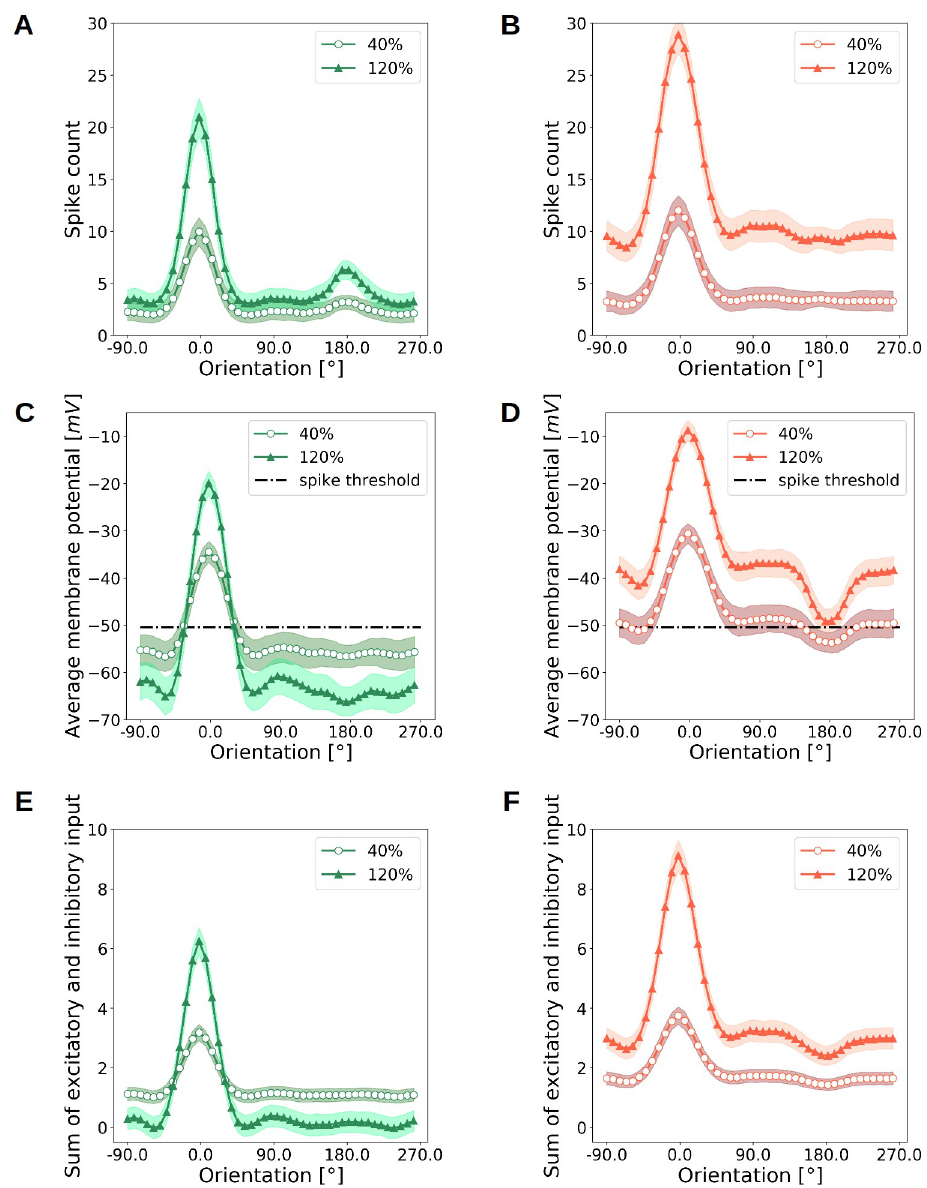
Fig 8. Emergence of contrast-invariant responses. A Average neural tuning curves for low and high contrast stimuli in the EI 2/1 model, B and the EI 3/1 model. C Average membrane potential (averaged across all neurons in the excitatory population) as a function of orientation and contrast level for the EI 2/1 model, D and the EI 3/1 model. E Sum of the excitatory and inhibitory input currents as a function of orientation and contrast level for the EI 2/1 model, F and the EI 3/1 model. In the EI 3/1 model, high-contrast stimuli with non-preferred orientations are associated with very different dynamics than in the EI 2/1 model: In the EI 2/1 model, the sum of excitatory and inhibitory currents is near zero for non-preferred orientations at high contrast ( E ). In the EI 3/1 model, the total synaptic current ( F ) remains large enough to elicit considerable membrane depolarization for non-preferred orientations at high contrast ( D ), reflected in elevated baseline activity and broader tuning ( B